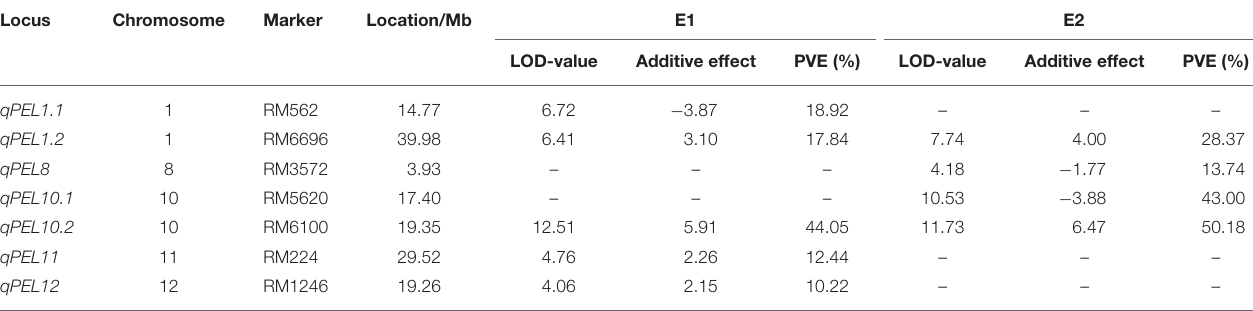
TABLE 2 | QTLs detected for the PEL trait and their genetic parameters in IIA-CSSL population across two environments. Locus Chromosome